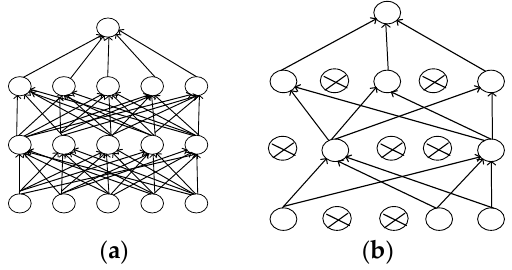
Figure 2. Neural network unit connections with different mechanisms. ( a ) Without the dropout layer mechanism; ( b ) With the dropout layer mechanism.